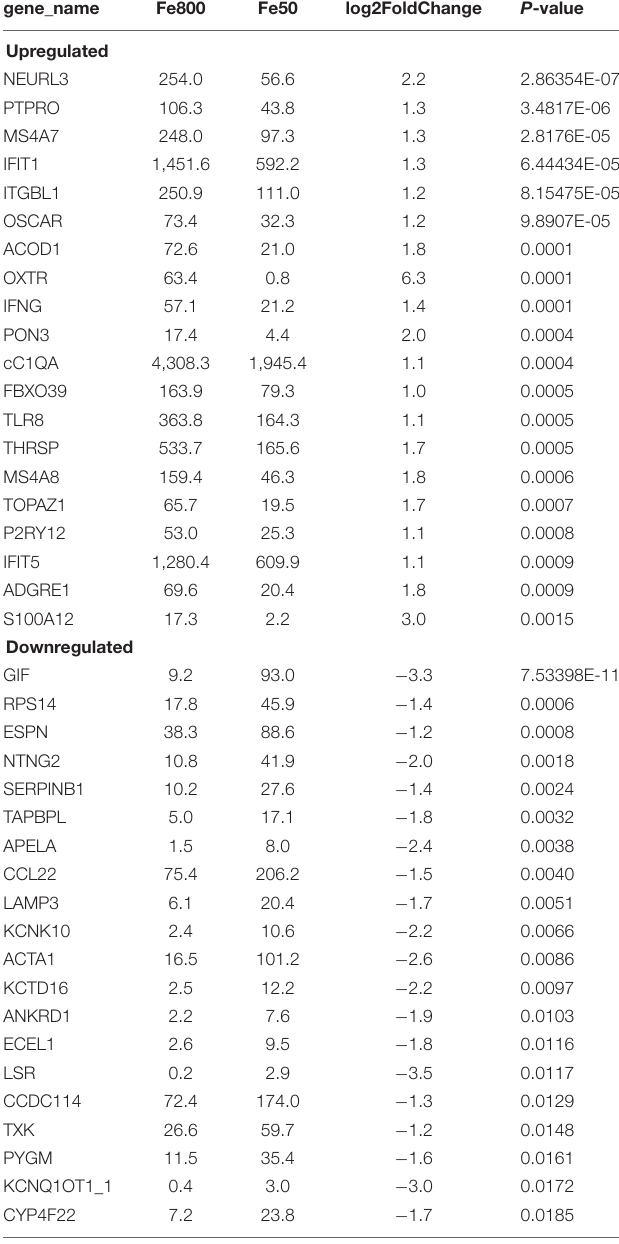
TABLE 3 | The top 20 up/downregulatory colonic gene